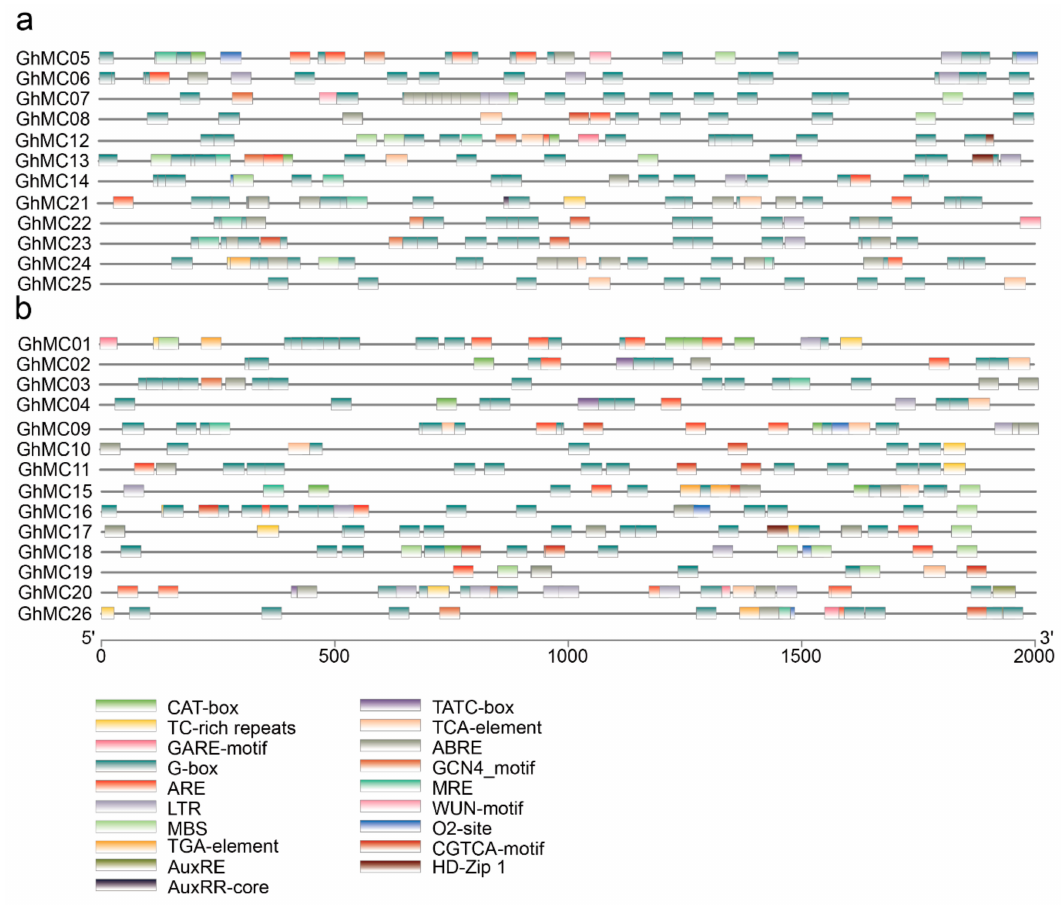
Figure 5. Analysis of cis-elements in GhMC genes. ( a ) Type-I GhMC genes; ( b ). Type-II GhMC